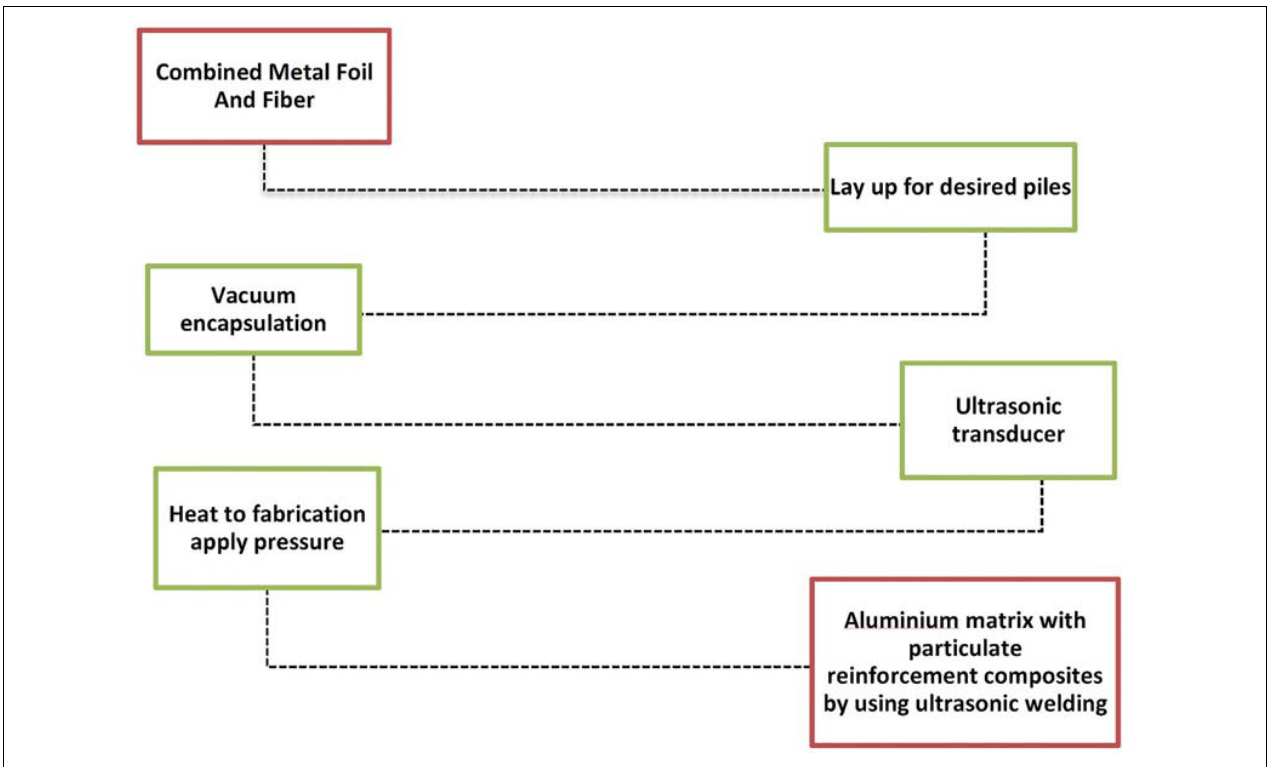
FIGURE 1 | The structure of the review for understanding the Ultrasonic Welding of Aluminum MMC. TABLE 1 | Comparison of processes for particulate reinforcements (Sijo and Jayadevan, 2016). Process followed Yield (Low/Medium/High) Size limit Probability of damage to Volume fraction the matrix during the process High Wide ranges of shapes, but Moderately high No data limitations on size. Height limits, up to 2 cm. Very high Up to